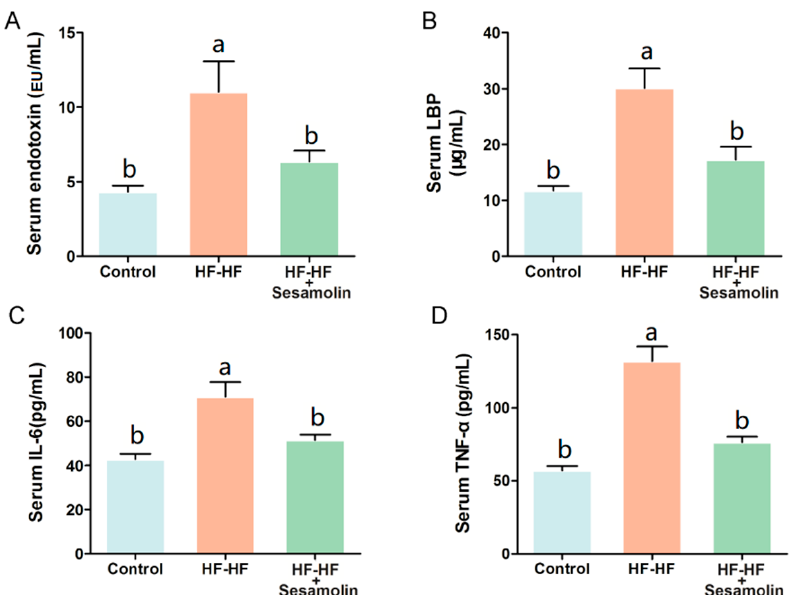
Figure 2. Sesamolin alleviates endotoxemia and systemic inflammation in HF ‐ HF diet ‐ fed mice. Serum levels of ( A ) endotoxin, ( B ) LBP, ( C ) IL ‐ 6, and ( D ) TNF ‐α . Results are presented as mean ± SEM (n = 8). Different letters express significant differences, p < 0.05.